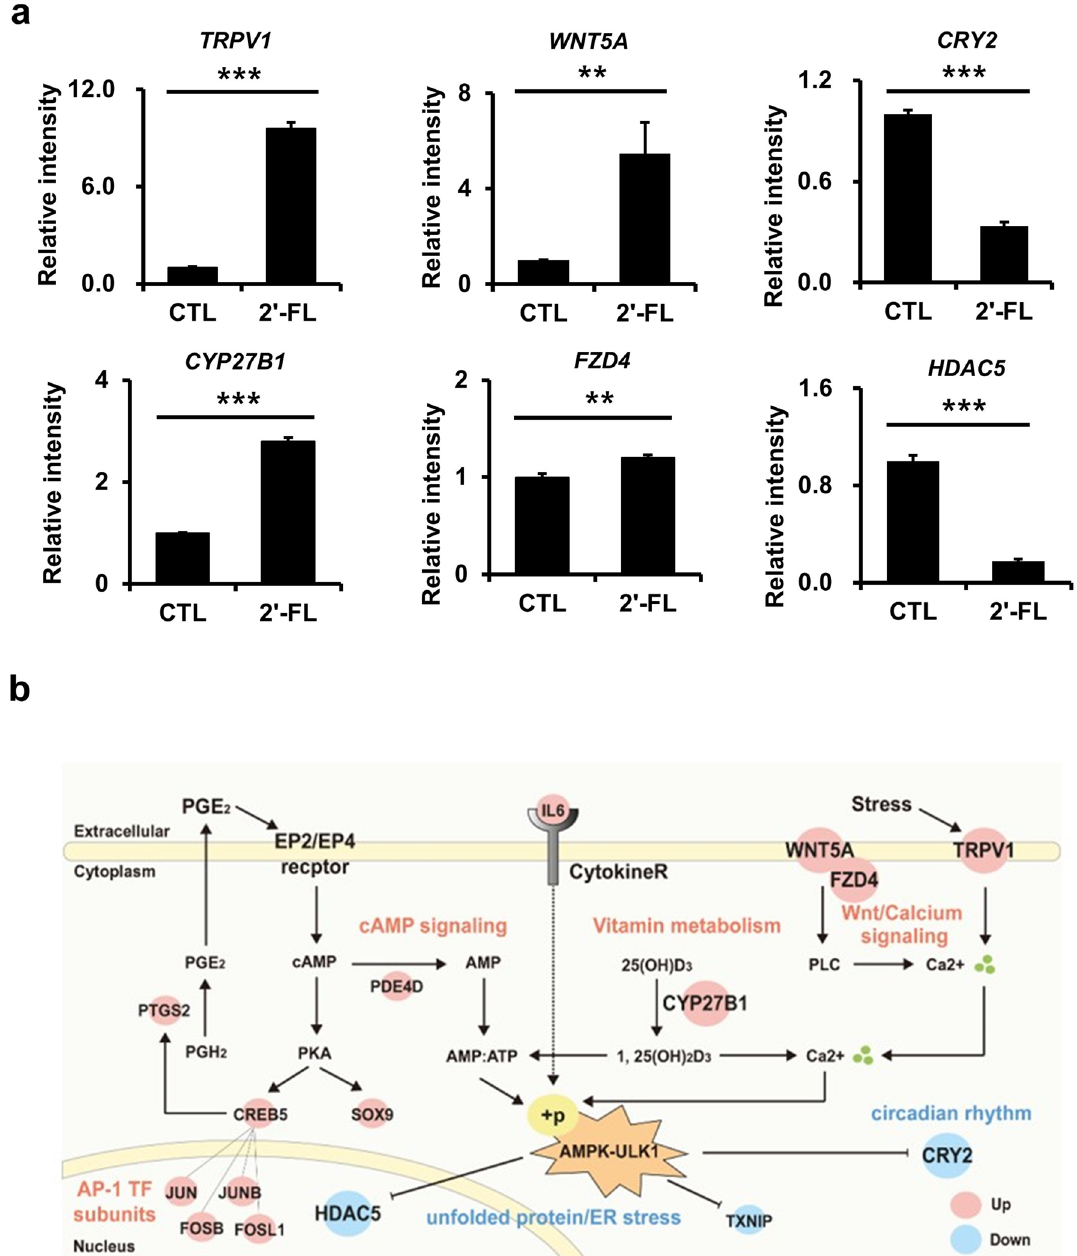
Figure 2. Transcriptome analysis reveals 2’-Fucosyllactose is associated with autophagy via the AMPK- ULK axis. ( a ) Quantitative RT-PCR analysis of six DEGs . GAPDH expression was used as reference. Data are represented as mean ± SD. * P < 0.05, ** P < 0.01, *** P < 0.001 by Student’s t -test. ( b ) Network model describing the relationships between the enriched GOBPs/KEGG pathways upon 2’-FL treatment in. Large nodes indicate the genes examined in ( a ). Gray solid lines denote protein–protein interactions. Arrows and inhibition symbols represent activation and suppression,